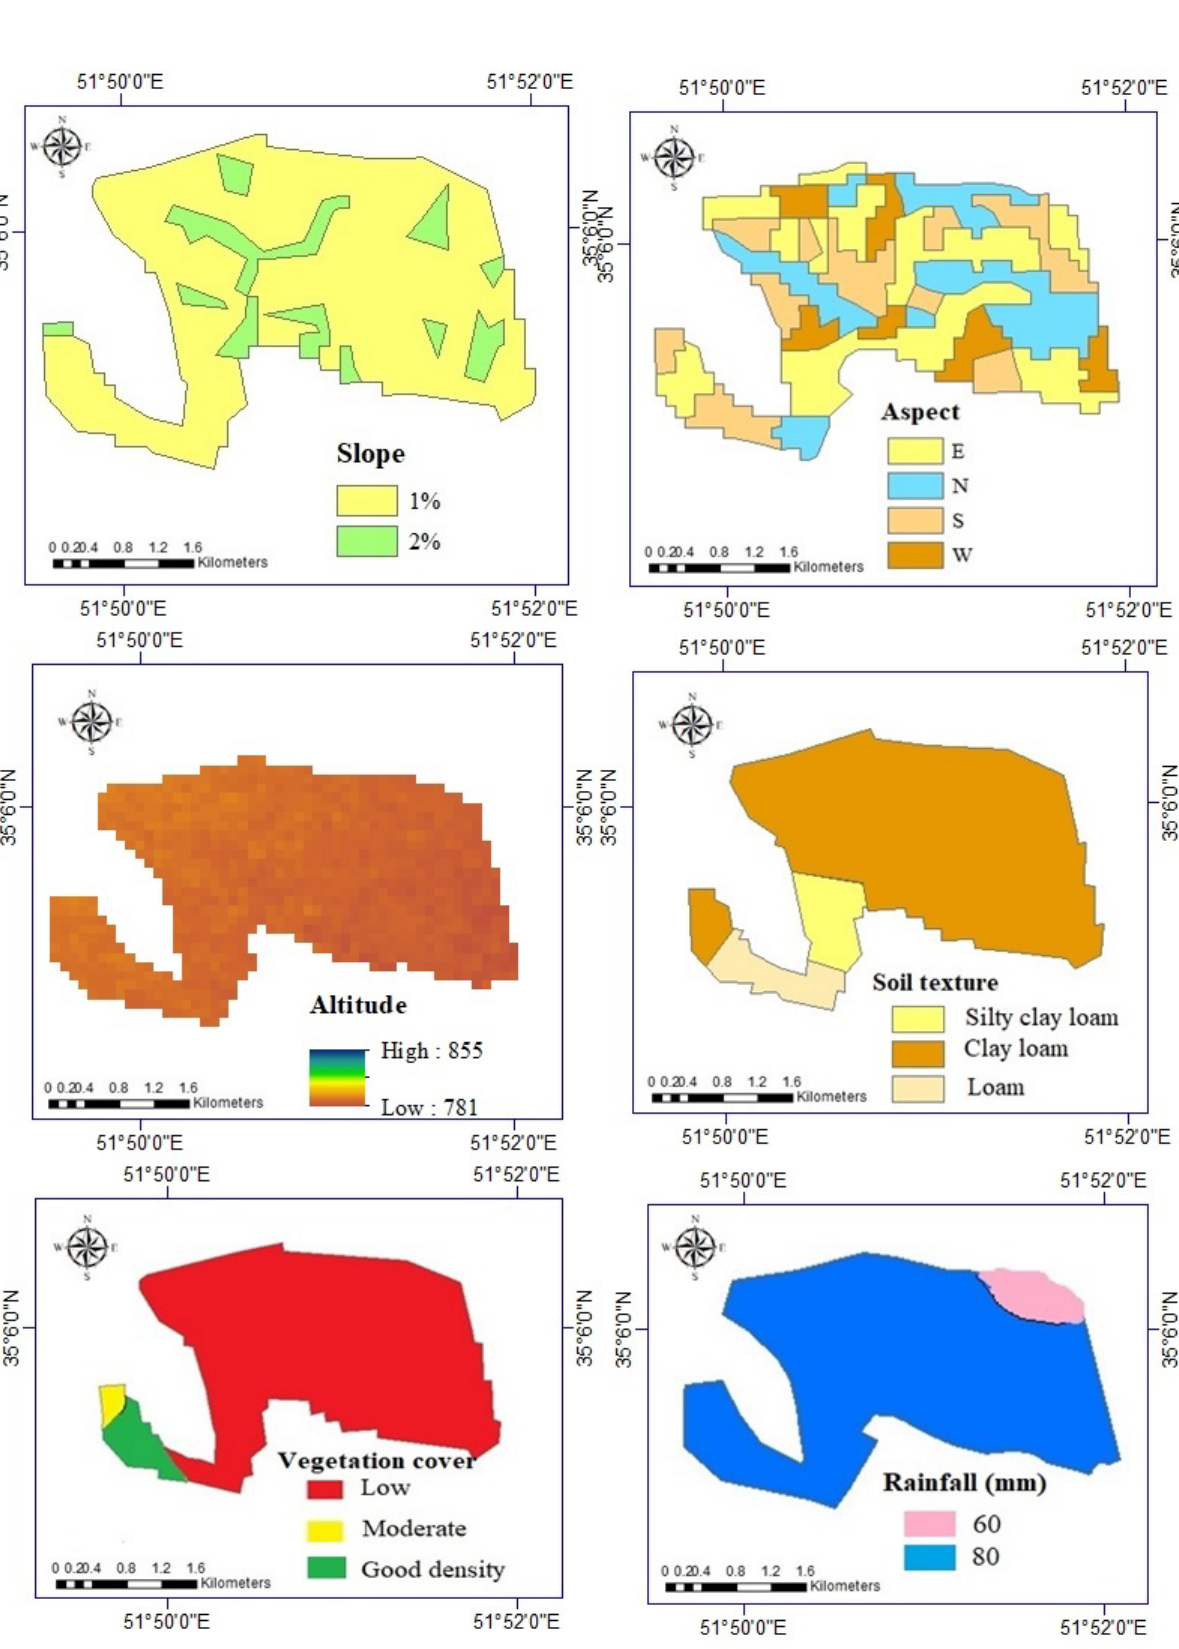
Figure 5. Classification map of ecological factors in Dolatabad region.